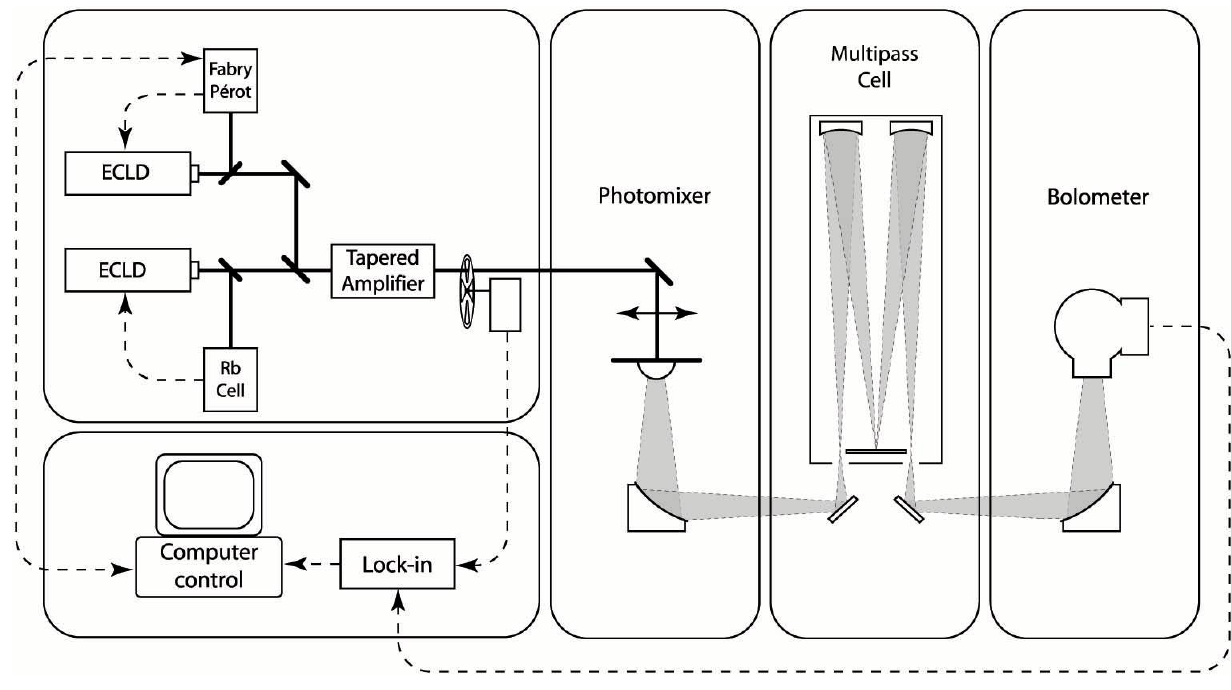
Figure 1. Photomixing spectrometer for high-resolution spectroscopy of